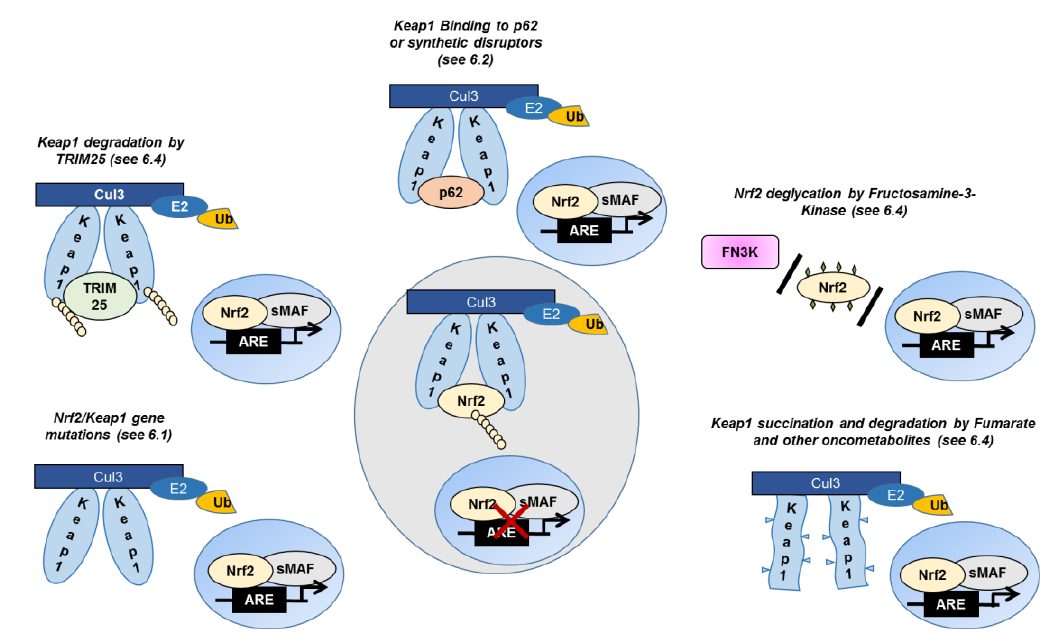
Figure 3. Distinct mechanisms leading to Nrf2 activation in cancer cells. The figure illustrates some of the best known mechanisms leading to the activation of the Keap1/Nrf2 pathway. Details are illustrated in the text. In the center of the figure is depicted an unstressed condition, where Nrf2 is bound to Keap1 and targeted to proteasomal degradation; nuclear translocation cannot thus take place. Numbers in brackets indicate the paragraph where the mechanism is described.